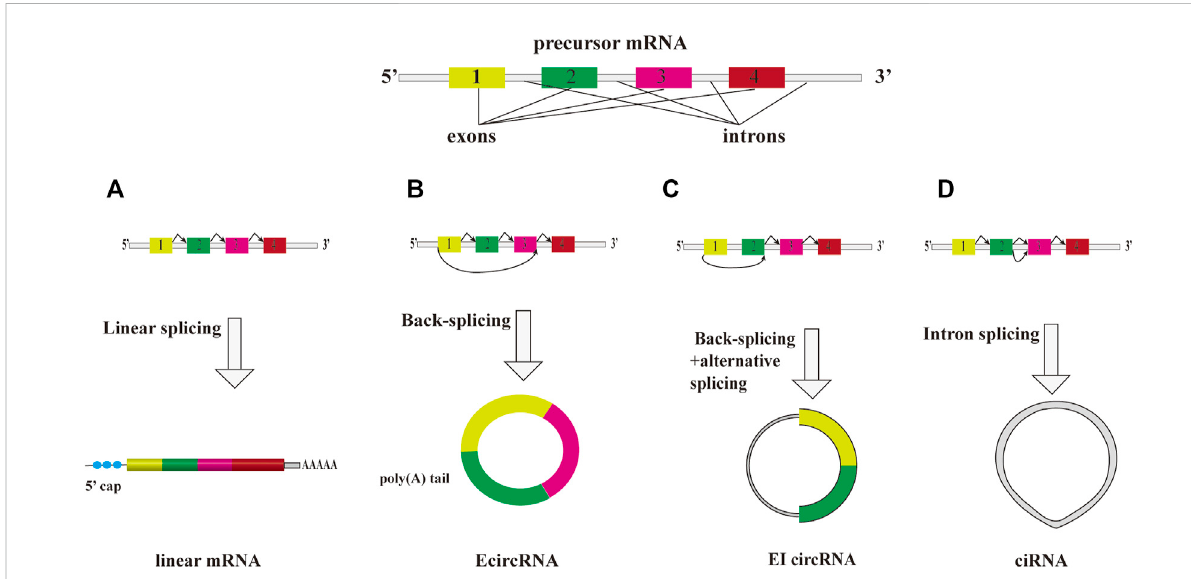
FIGURE 1 TheoverviewdiagramshowsbiosyntheticpathwaysofthreemajorsubclassesofcircRNAs.AprecursormRNA(pre-mRNA)canproducealinear mRNAandcircRNAs. (A) AprecursormRNA(pre-mRNA)canproducealinearmRNAundergocanonicalsplicing.Underback-splicing,itcanproduce acircRNA.Theyarethreemajor subclassesofcircRNAs,EcircRNA,ciRNAandEIcircRNA. (B) EcircRNAisthemaingroupofcircRNAclassthatconsist of only exon(s). (C) cirRNA is derived from intron lariat. (D) EIcircRNA is composed of at least two exons and one retained